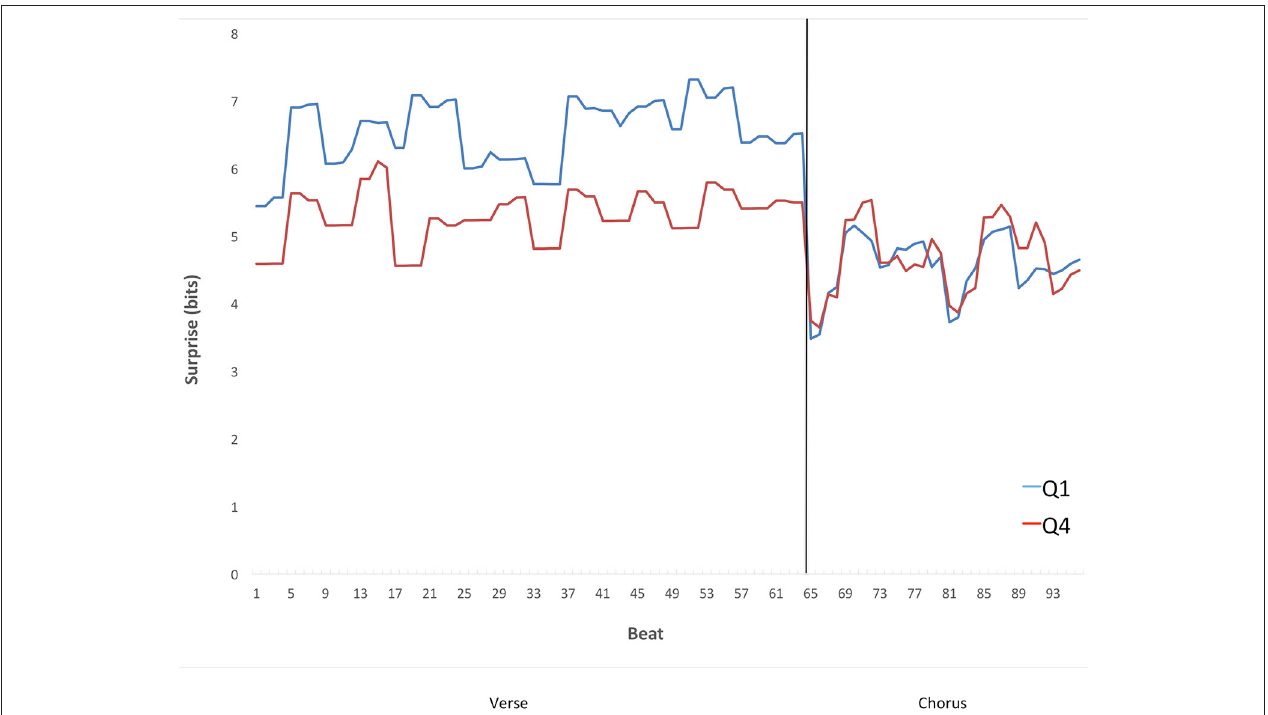
FIGURE 9 | Mean surprise as a function of time in the transition from verses preceding a chorus to the subsequent choruses from Q1 and Q4 songs, within the subset of verses that are 16 bars long, and within the subset of choruses that are 8 bars long. The per-section average surprise falls from the verses to the choruses in Q1 but not Q4. The fall in Q1 songs is consistent with the Contrastive-Surprise